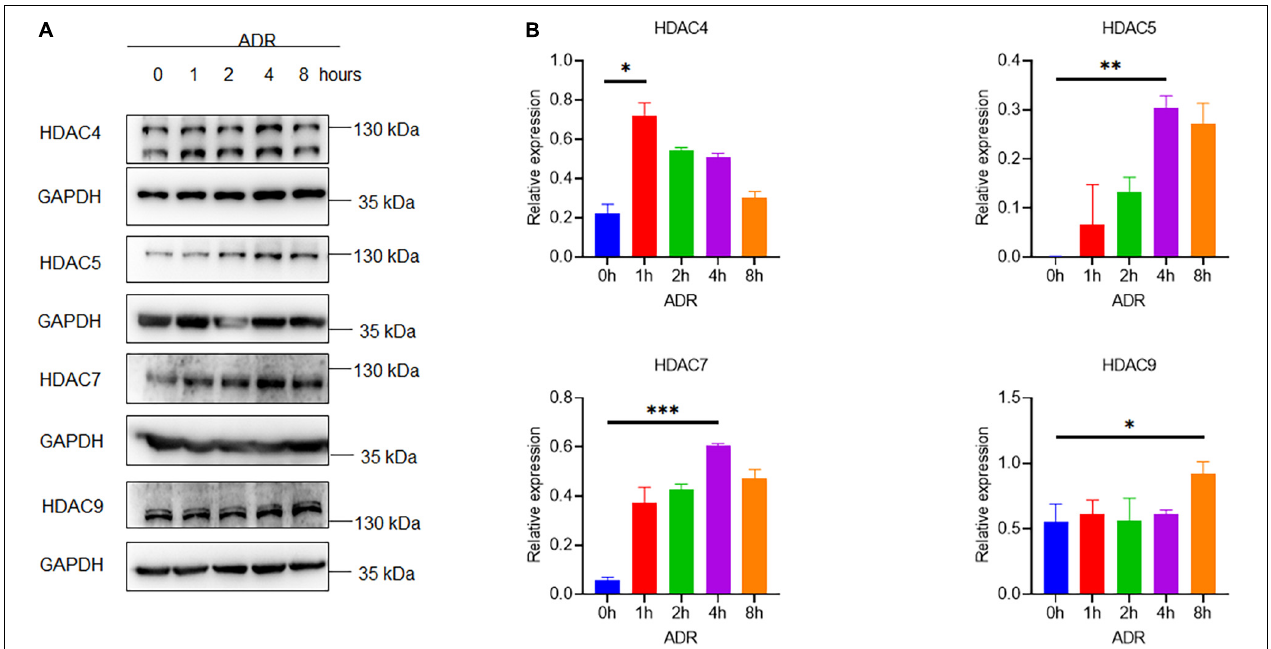
FIGURE 3 | Histone deacetylase IIa expression in ADR-treated podocytes. (A,B) Representative Western blots with quantification for HDAC IIa members in ADR-treated podocytes statistical analysis was performed with two-way ANOVA. ∗ p < 0.05; ∗∗ p < 0.01; ∗∗∗ p < 0.001.